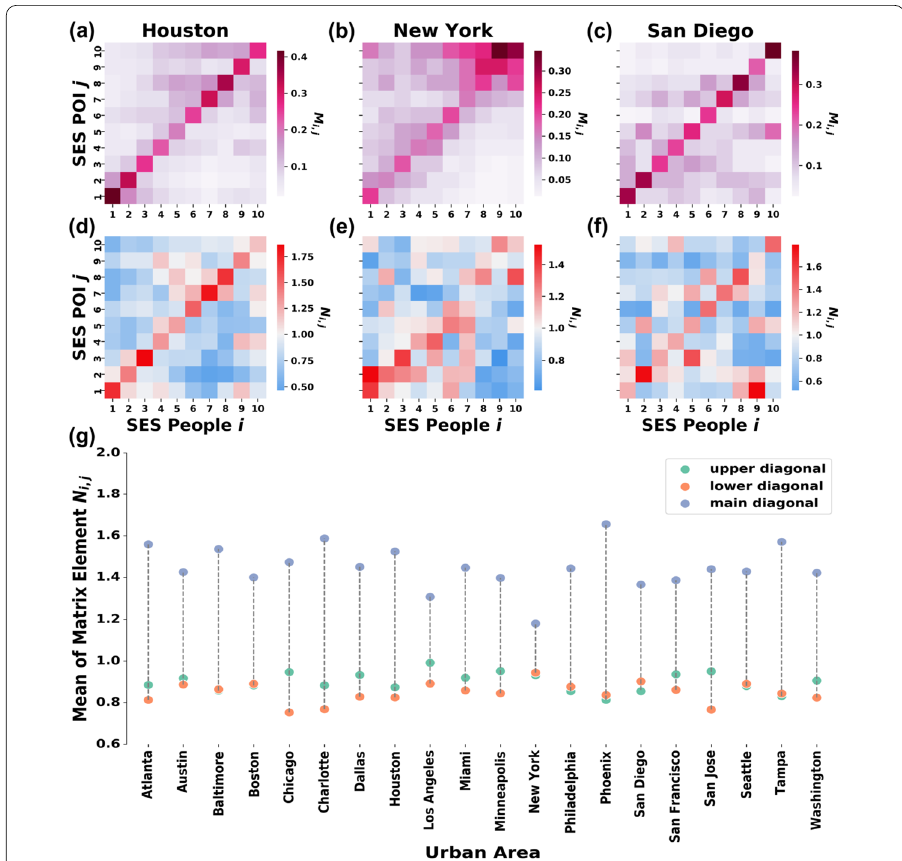
Figure 2 Socioeconomic stratification matrices. ( top ) Empirical stratification matrices M i , j , showing the probabilities that individuals from a given class visit to places of different classes. The darker colour shades of bins represent larger visiting probability. Matrices of Houston (Fig. 2( a )), New York (Fig. 2( b )) and San Diego (Fig. 2( c )) all show strong stratification patterns, indicating that people tend to visit most likely places with similar status. The normalised stratification matrices N i , j , defined as the fraction of the empirical and randomised stratification matrices. After normalisation, such stratification pattern becomes less evident for New York (Fig. 2( e )) and San Diego (Fig. 2( f )) but quite persistent in Houston (Fig. 2( d )). Similar matrices computed for other urban areas are available in Additional file 1, Section B. ( bottom ) Mean of matrix element N i , j , computed separately for the upper, lower, and main diagonals. Among 20 urban areas, 12 of them (including Houston) have higher mean values for upper diagonal elements, indicating dominant upward visiting biases. In contrast, we see dominant downward visiting biases in San Diego, while mean values of upper and lower diagonal elements are almost indistinguishable in New York (respectively 0.932 and